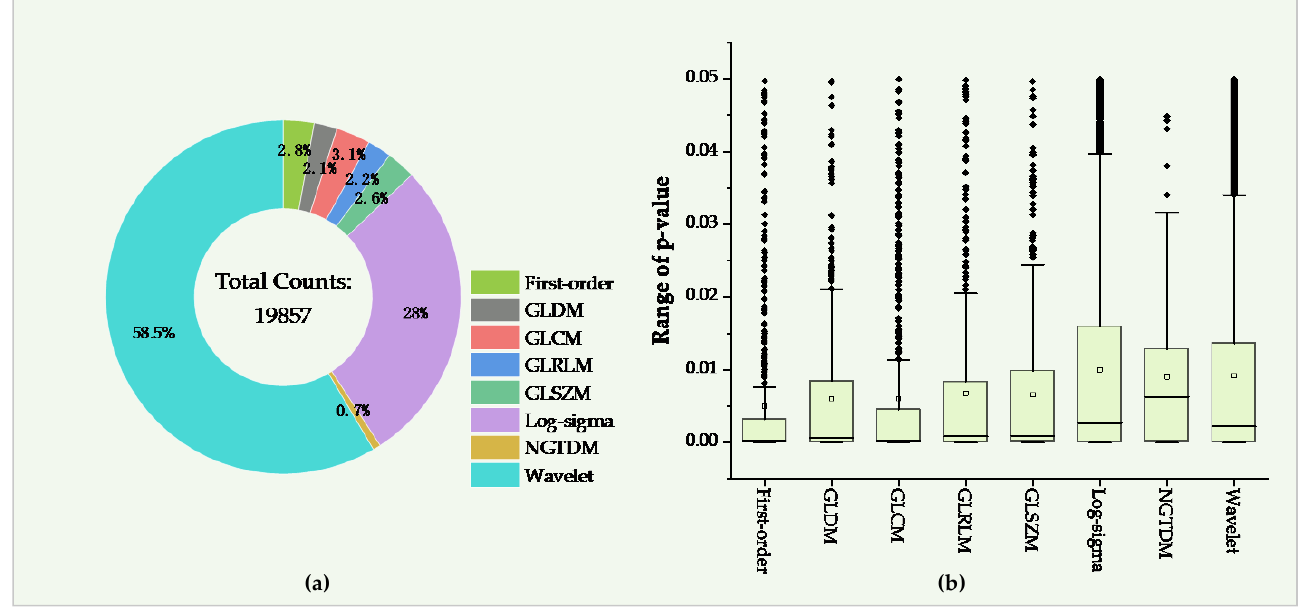
Figure 4. Significant features in the radiomics features group. ( a , b ) Ratio and p -value of significant features in the eight radiomics feature groups, respectively. Table 5. Statistics of p -values of significant features in each radiomics group.